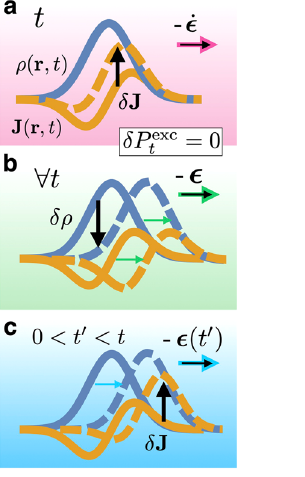
Fig. 3 Illustrations of the effects induced by shifting in nonequilibrium. All transformations affect both the density pro fi le ρ ( r , t ) (blue) and the current pro fi le J ( r , t ) (yellow), while the superadiabatic excess power ¼ 0. Here t indicates the time and r is the functional is invariant, δ P exc t position coordinate. a An instantaneous spatial shift by _ ϵ at time t induces a current change δ J ¼ (cid:3) _ ϵ ρ . b A static shift by ϵ = const is applied at all times t . c A time-dependent shift ϵ ð t 0 Þ is applied between initial time 0 and fi nal time t of the considered time